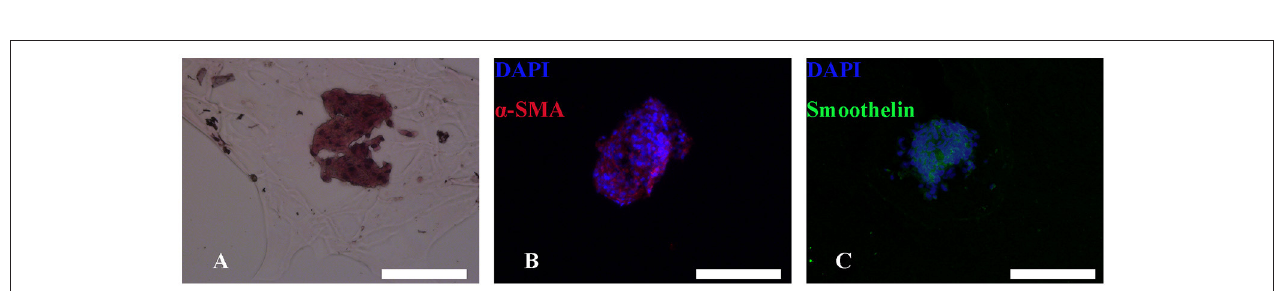
FIGURE 6 | Bioprinted 3D structure immersed in culture medium (A) , optical observation of MTs ( B , white arrow) and hADSCs ( C , black arrow) in the bioprinted structure. Inset bar = 200 µ m.